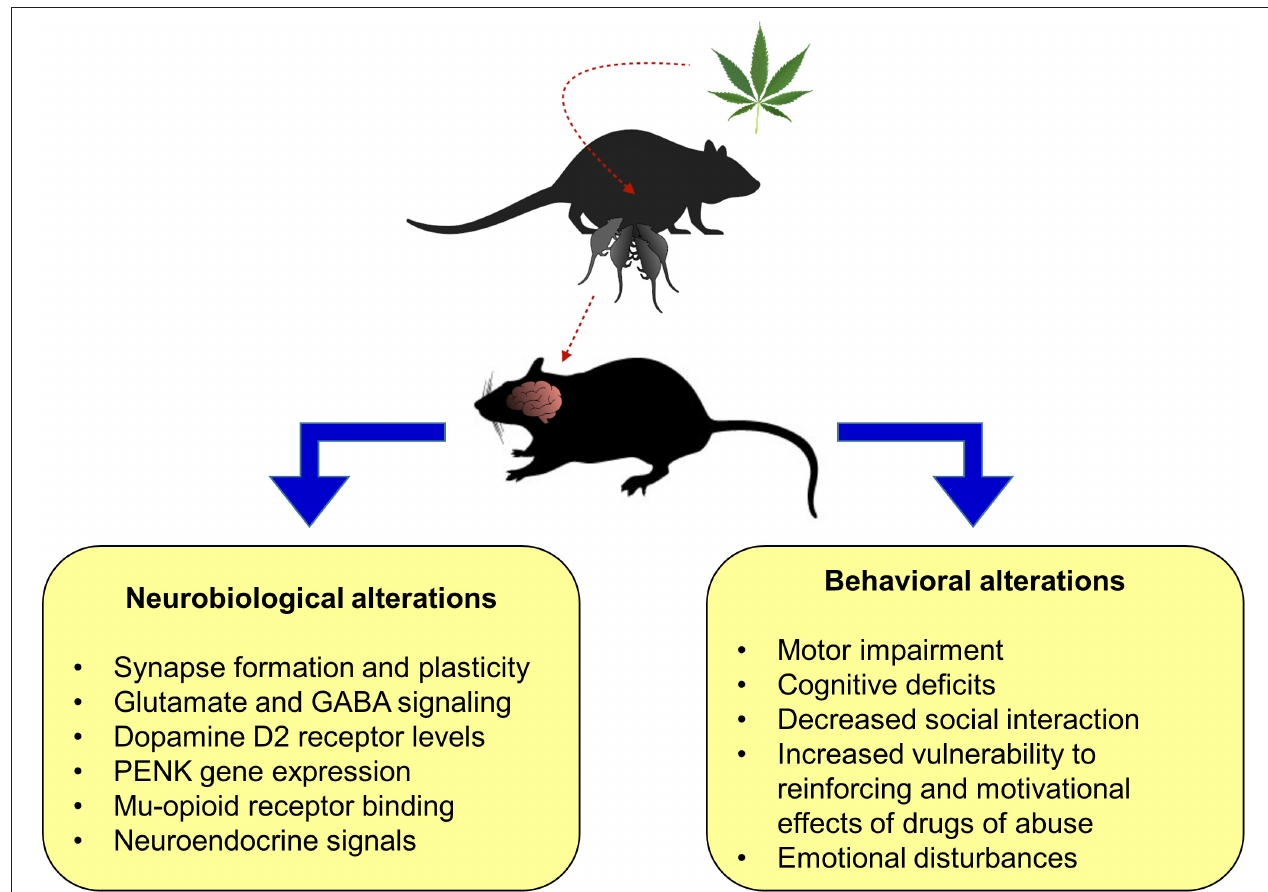
FIGURE 3 | Main preclinical findings from perinatal cannabis exposure in rodent animal models on neurobiological and behavioral alterations in the litter. PENK,